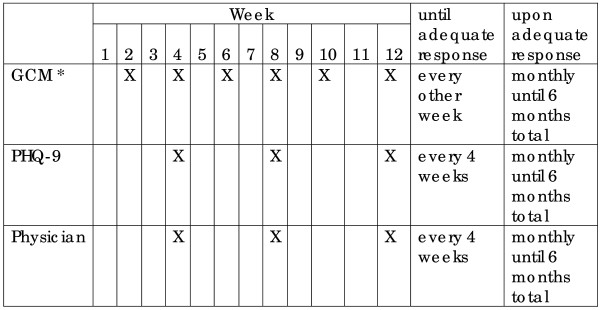
Schedule for Follow-up Contacts with Patients. *Discuss compliance with medication plan, barriers to adherence, depressive symptoms, level of functioning, side effects, questions/concerns, need for psychiatric referral or consultation with program psychiatrist. GCM is the Generalist Care Manager. PHQ-9 is the Patient Health Questionnaire-9 measure of depressive symptoms